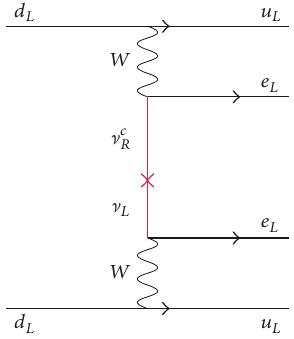
Figure 1: Canonical 0 ] 𝛽𝛽 due to light massive neutrinos.